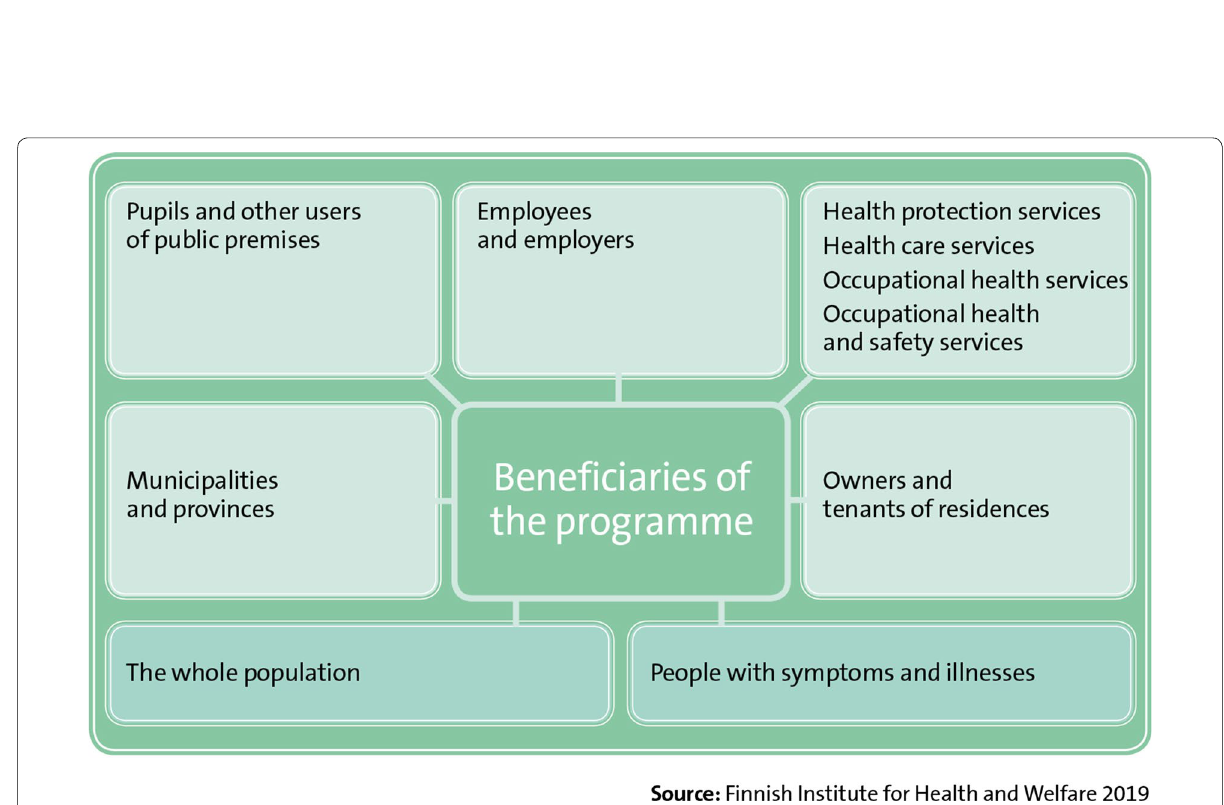
Fig. 12 Beneficiaries of the Finnish Indoor Air and Health